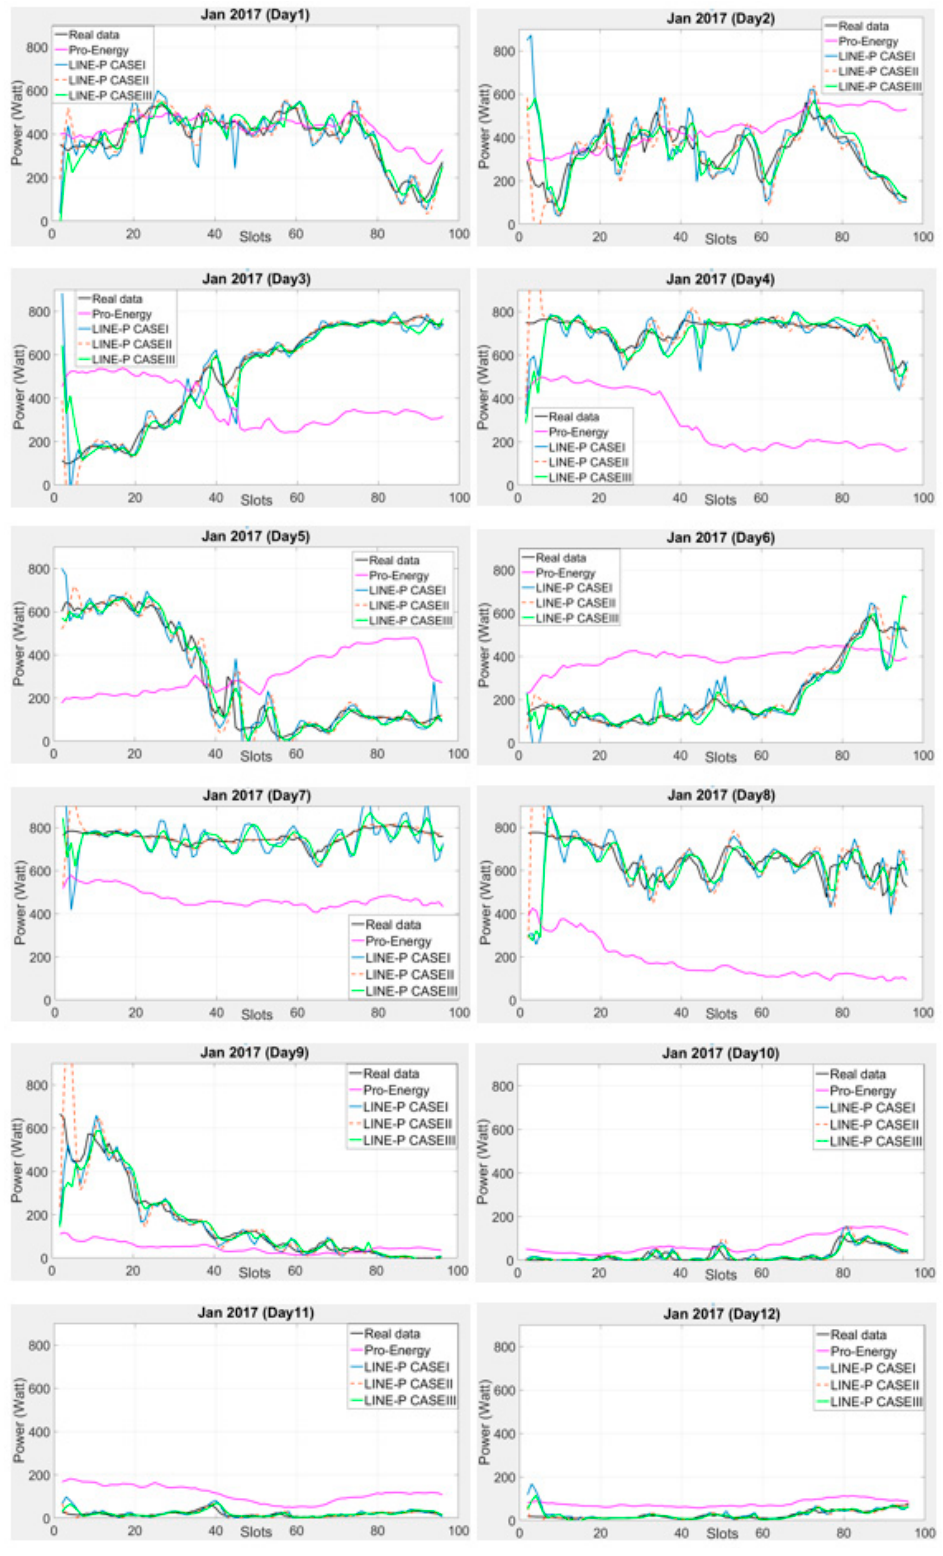
Figure 5. Graphical comparison of the obtained predictions for LINE-P (all cases) and Pro-Energy for shorter interval-based (96 slots) wind energy in December (12 days) and dataset [11]. Generally speaking, the estimates provided by LINE-P are more accurate than those of Pro-Energy.